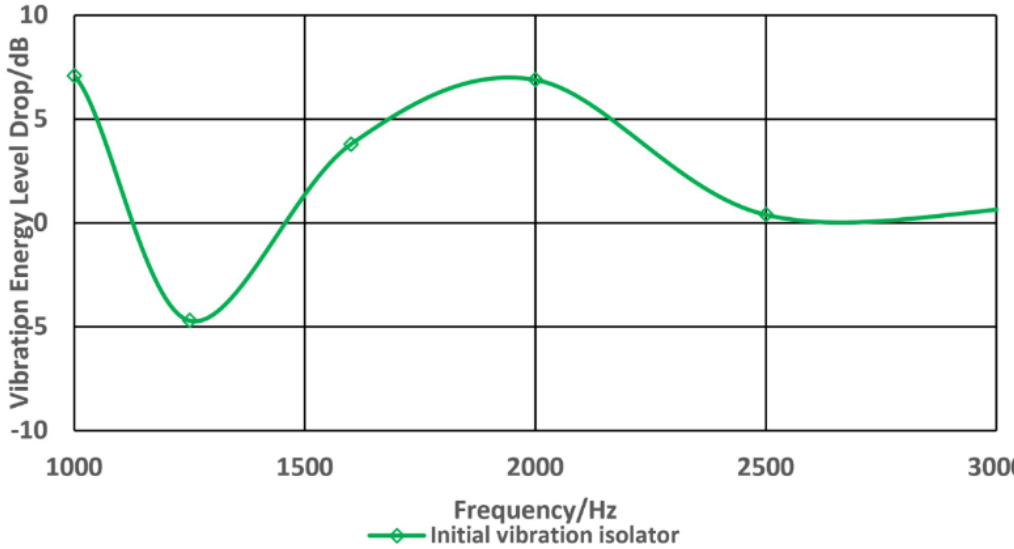
Figure 6. Vibration level drop test results of initial isolator.